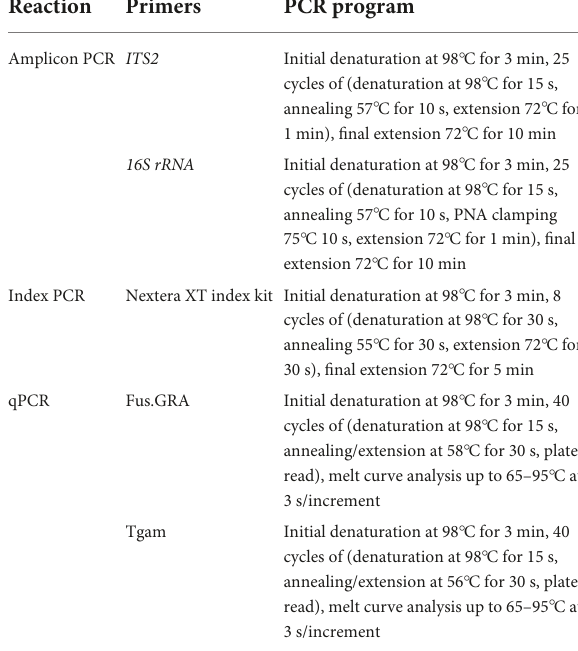
TABLE 1 The PCR conditions used for amplicon generation, indexing, and quantitative